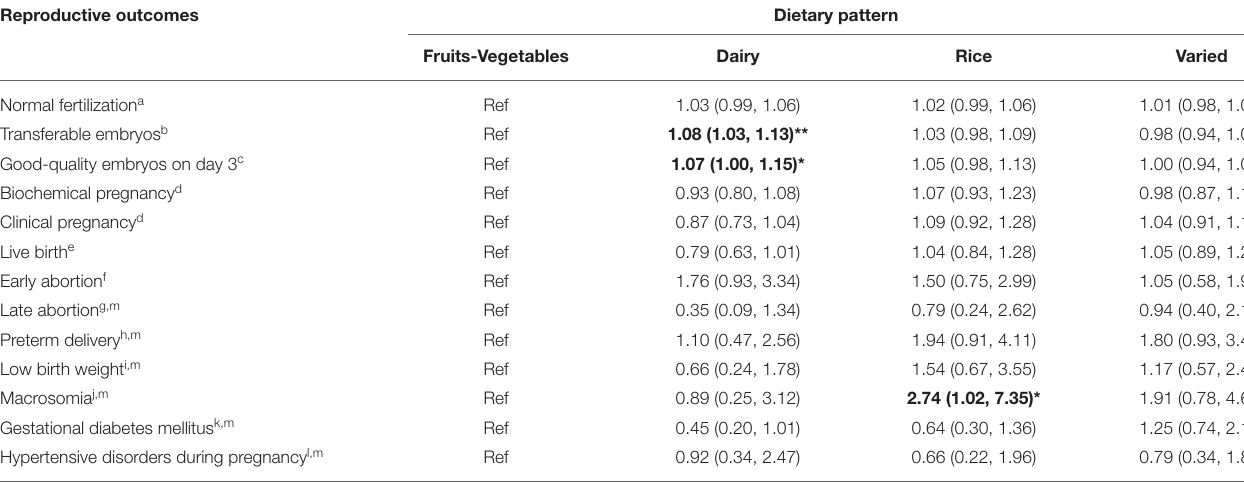
TABLE 7 | Associations between the dietary patterns derived by cluster analysis and reproductive outcomes. Reproductive outcomes Dietary pattern Fruits-Vegetables Dairy